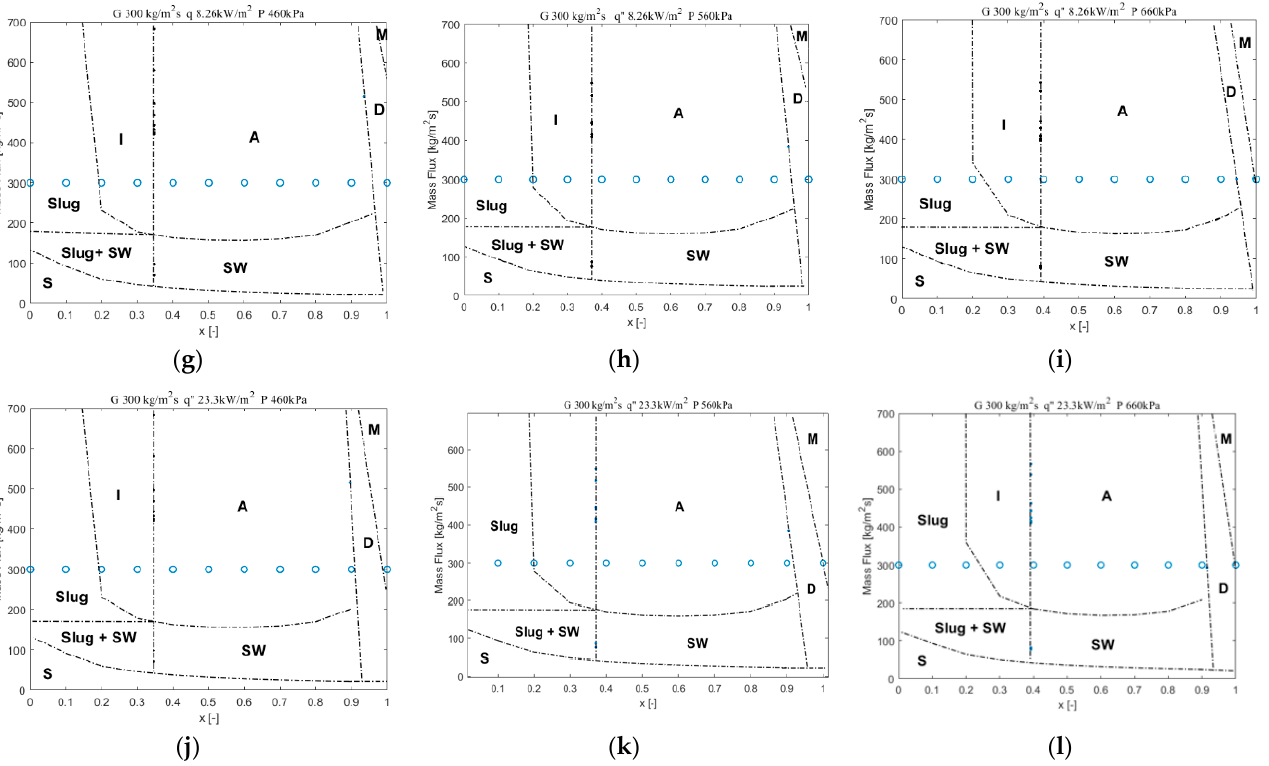
Figure 9. Flow pattern predictions by Wojtan et al. for increasing saturation pressures from 460 kPa to 660 kPa at G 150 kg/m 2 s, q ″ 8.26 kW/m 2 ( a – c ), G 150 kg/m 2 s, q ″ 23.3 kW/m 2 ( d – f ), G 300 kg/m 2 s, q ″ 8.26 kW/m 2 ( g – i ) and G 300 kg/m 2 s, q ″ 23.3 kW/m 2 ( j – l ).